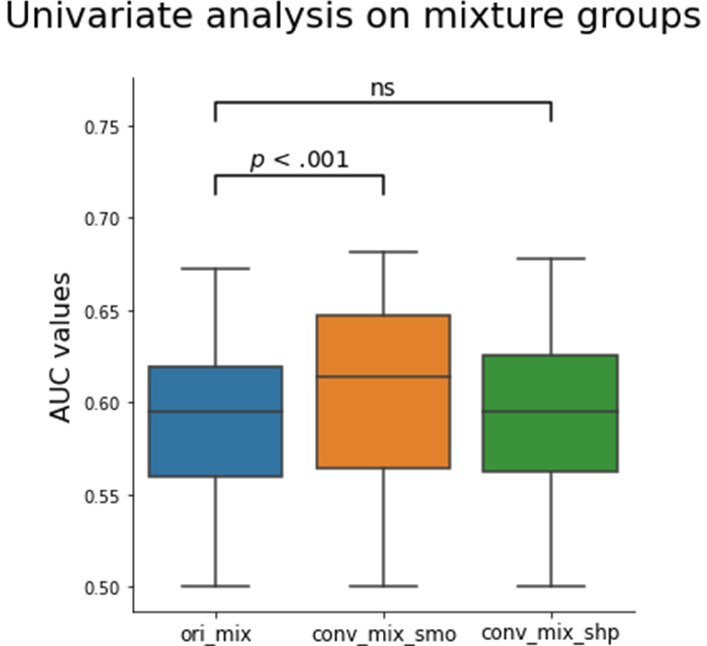
Figure 5. Box plot of the calculated AUC values for all 1158 features before and after the CNN kernel conversion on the mixture groups. Only the conv_mix_smo group was significantly different from the ori_mix group (Z = 15.1, p < 0.001). The median AUC values were 0.595 ± 0.006, 0.614 ± 0.028, and 0.595 ± 0.028 for ori_mix, conv_mix_smo, and conv_mix_shp groups, respectively. The Z values were 15.1 and 0.01 for conv_mix_smo and conv_mix_shp, respectively, when compared to the ori_mix group. The Z-values were calculated using two tailed Wilcoxon signed ranked test. ns = not significant. Table 4. The top three radiomic features with the highest AUC values compared among different mixed group settings. Reproducibility (CCC)